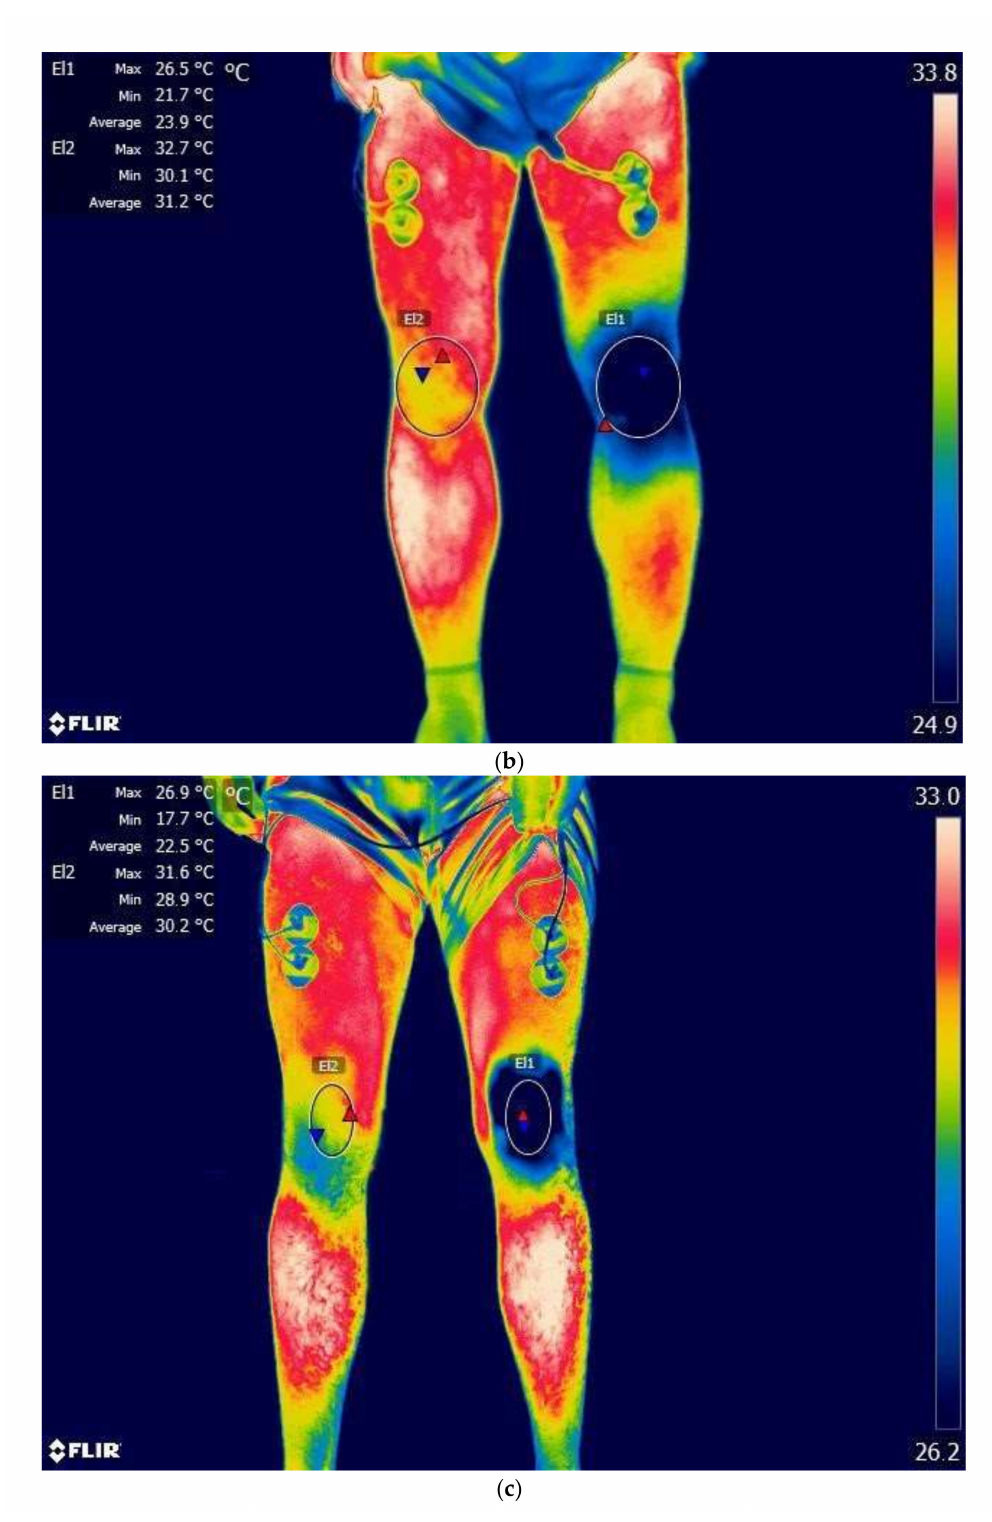
Figure 2. Lower limb thermogram with marked areas (El1- ROI E , El2- ROI NE ); ( a ) liquid nitrogen vapors; ( b ) cold air; ( c ) ice